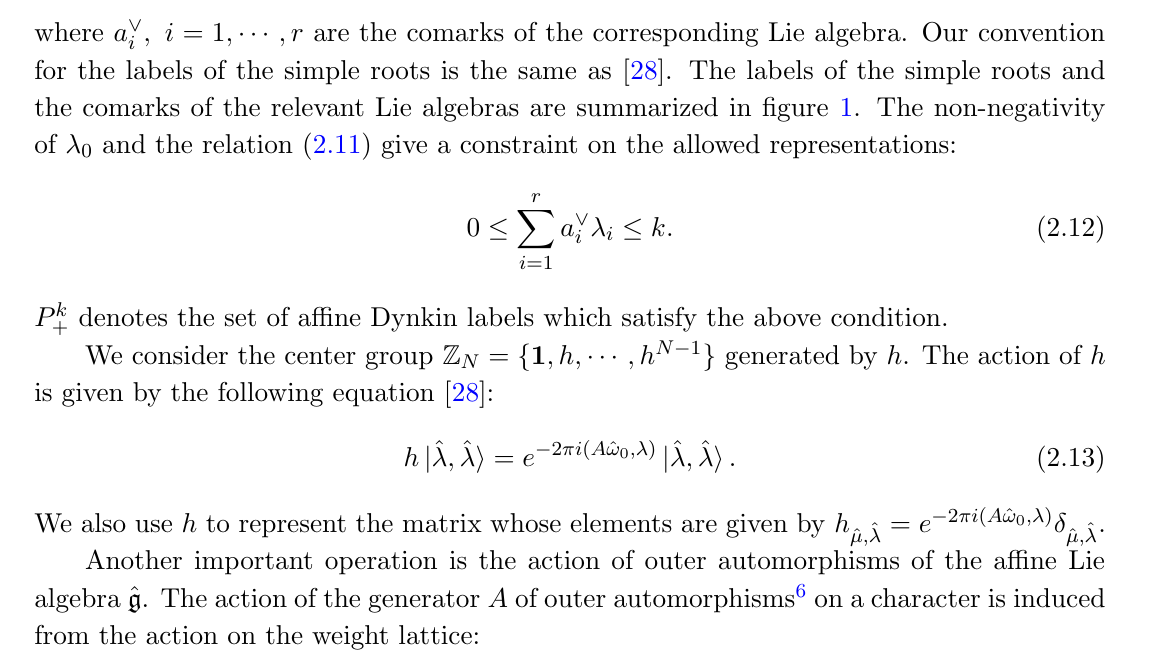
where a _ ; i = 1 ; (cid:1) (cid:1) (cid:1) ; r are the comarks of the corresponding Lie algebra. Our i